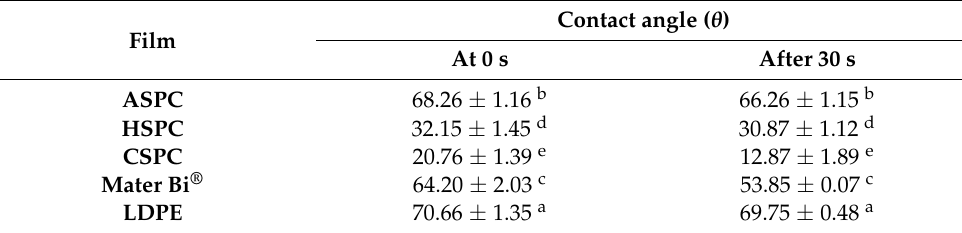
Table 4. Contact angle values of argan seed protein concentrate (ASPC)-based films compared to those prepared with hemp seed protein (HSPC) and cardoon seed protein (CSPC) concentrates, and to Mater Bi ® and low density polyethylene (LDPE) films. Different superscript letters (a–e) indicate significant differences among the values reported in each column ( p < 0.05). Further experimental details are given in the text.